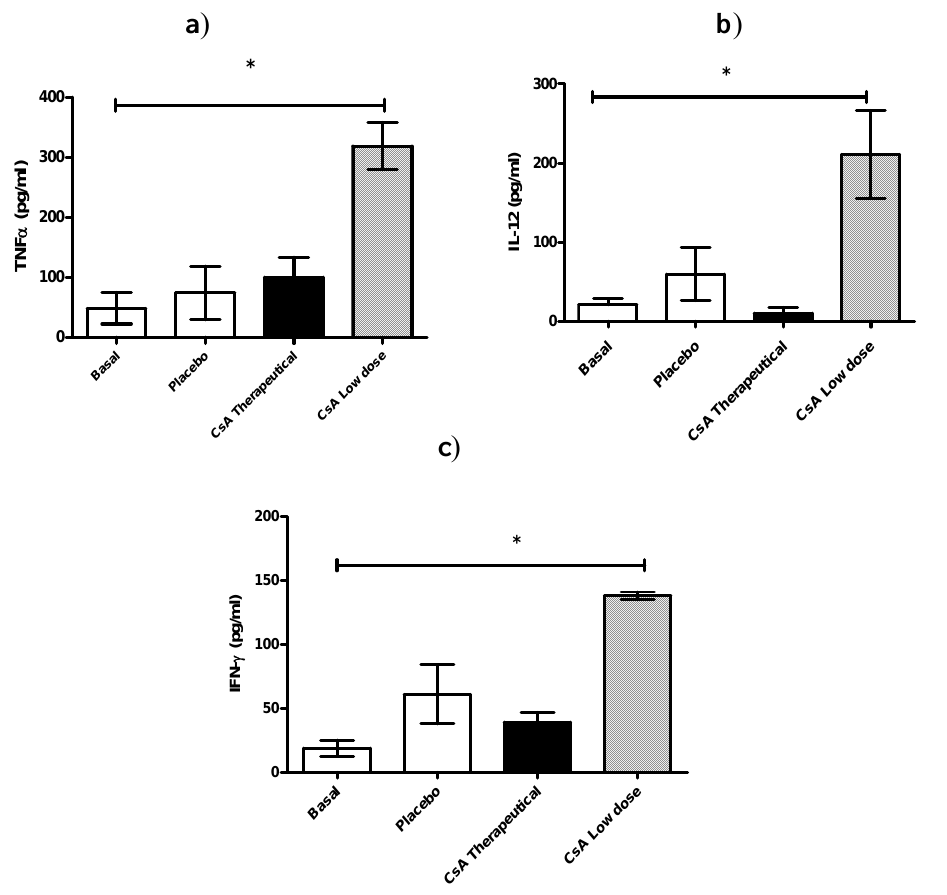
Figure 4. Effect of CsA on pro-inflammatory cytokine levels on sera early after